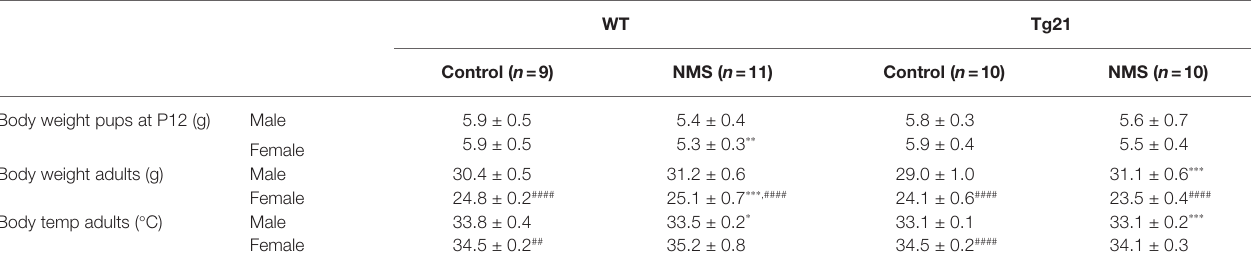
TABLE 2 | Body weight of animals at postnatal and adult ages.